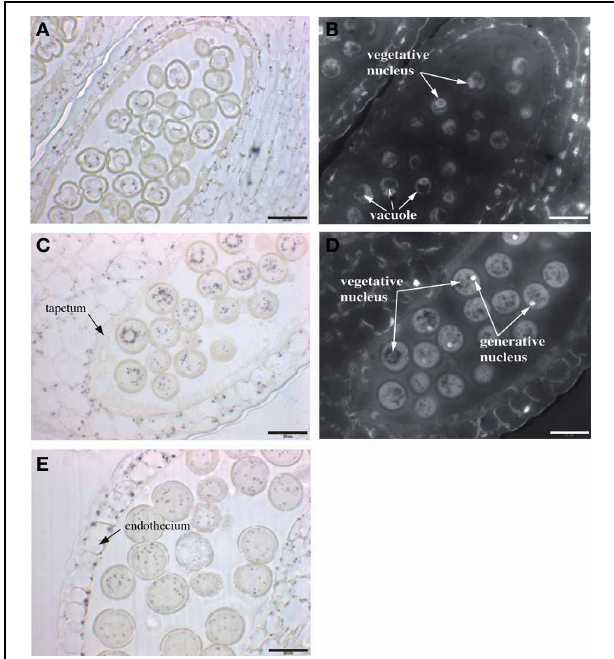
FIGURE 6 | Iron distribution during Arabidopsis pollen development. Sections of anthers at three different stages of pollen development were stained with Perls/DAB and DAPI. (A,B) mononuclear pollen grain, (C,D) binuclear pollen grain, (E) mature pollen grain. (A,C,E) Bright field images; (B,D) Epifluorescence images from slides (A,C) , respectively, showing DAPI-stained vegetative and generative nuclei. Scale bars: 20 µ m.